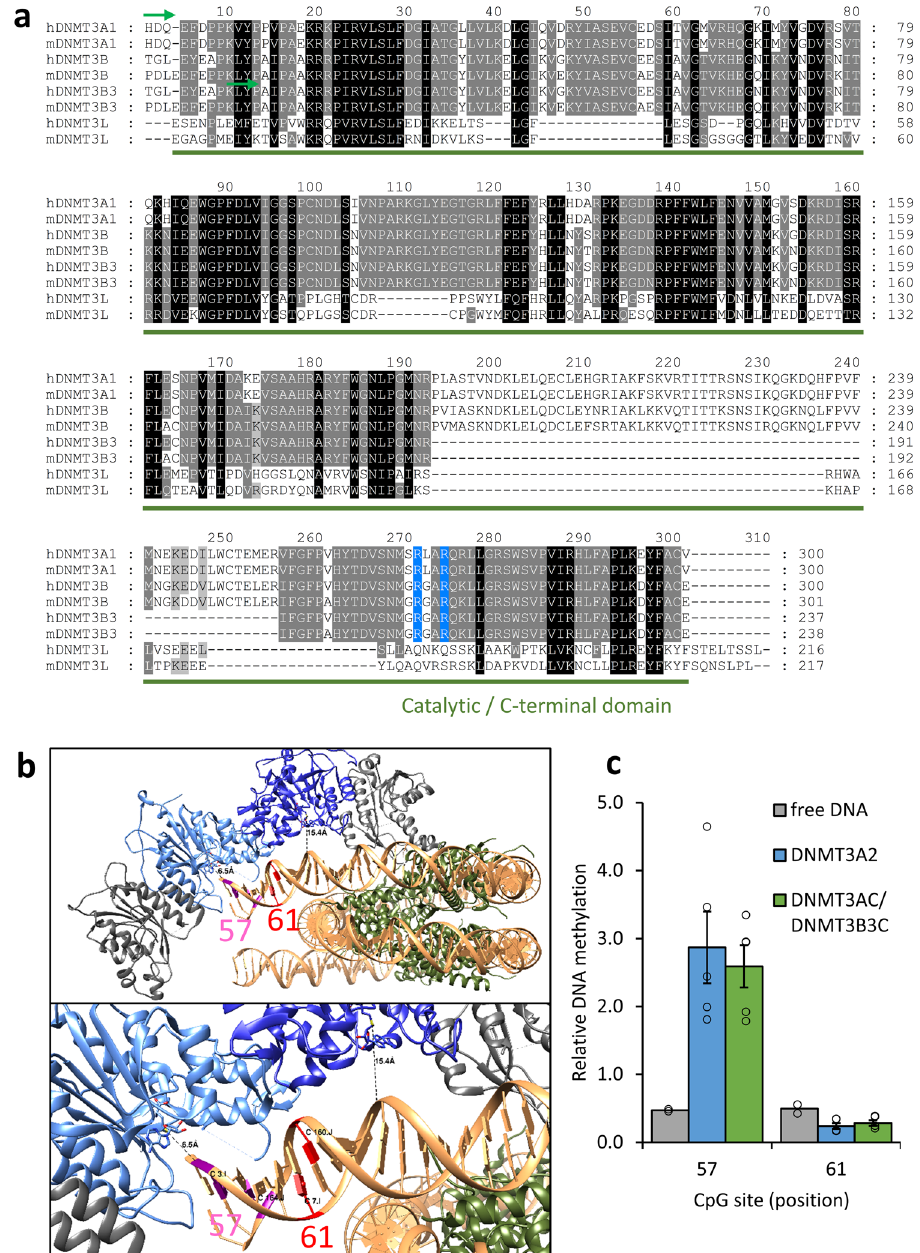
Fig. 2 Analysis of the linker DNA methylation pattern in the context of structural data. a Sequence alignment of human and mouse DNMT3A, DNMT3B, DNMT3B3, and DNMT3L showing the C-terminal parts of the enzymes. The fi rst residues resolved in the DNMT3A2/3B3-nucleosome structure are labeled by green arrows. The key DNMT3B3 residues interacting with the nucleosome acidic patch (R740 and R743, highlighted in blue) are conserved between DNMT3A and DNMT3B. The full alignment is shown in Supplemental Fig. 1. b Overview of the cryo-EM structure of the DNMT3A/3B3- nucleosome complex (pdb 6PA7). The distal and proximal DNMT3A subunits are colored light and dark blue, the outer DNMT3B3 subunits are colored gray. CpG sites 57 and 61 are marked in purple and red. The lower panel shows an enlarged view focusing on the 10 bp linker DNA. c Comparison of the relative methylation levels of CpG sites 57 and 61 in the nucleosome methylation experiments with DNMT3A2 and DNMT3AC/3B3C, as well as in free DNA methylation by DNMT3A2. Error bars represent the SEM if n ≥